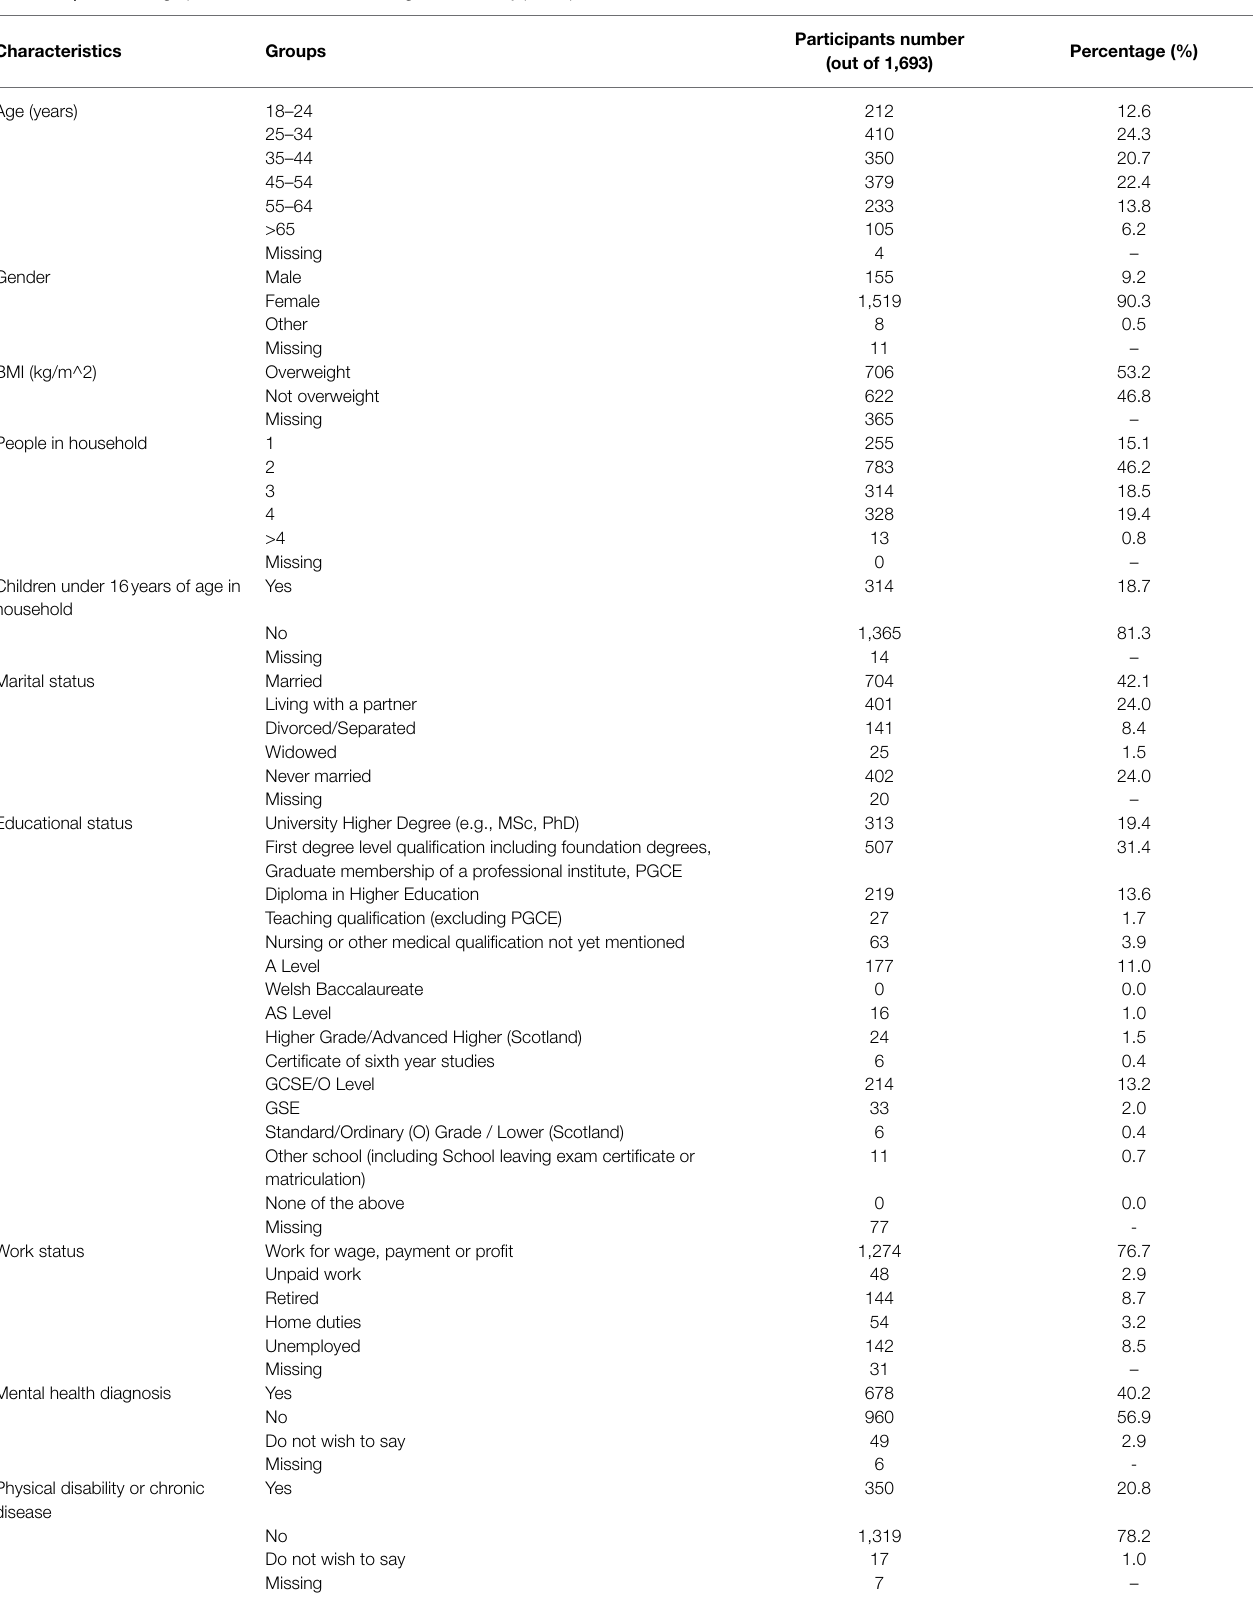
TABLE 2 | The demographic characteristics of the dog owner survey participants. Characteristics